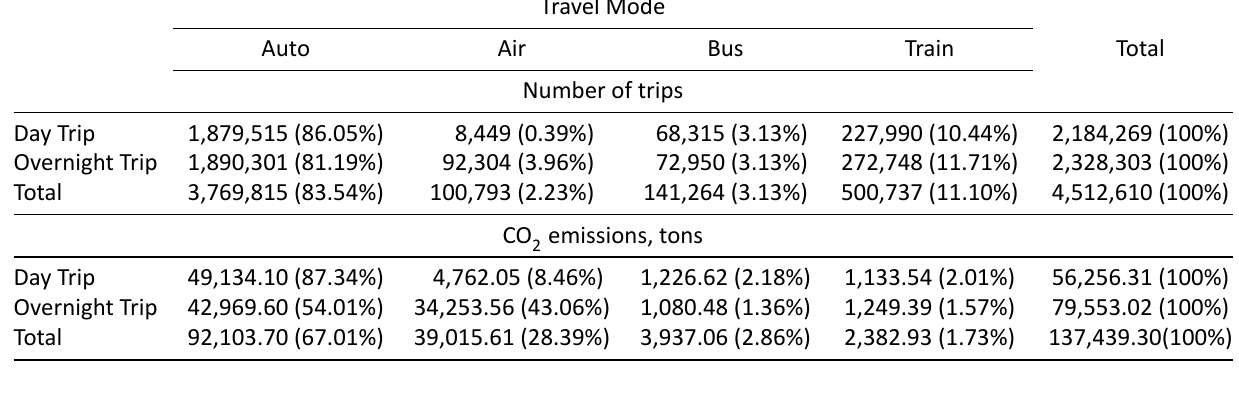
Table 6. Base scenario modal share of domestic long‐distance trips and CO